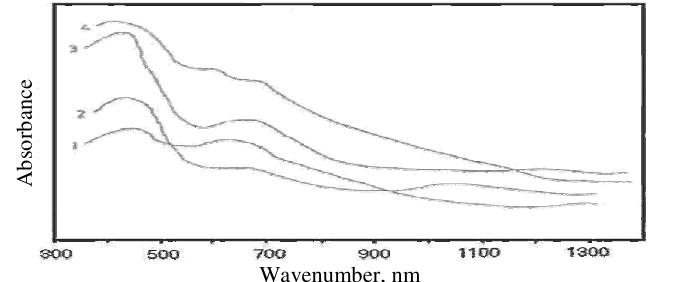
Figure 1 . Reflectance spectra of HL HL Mn (The band value in nm is converted into cm -1 and discussed in 2